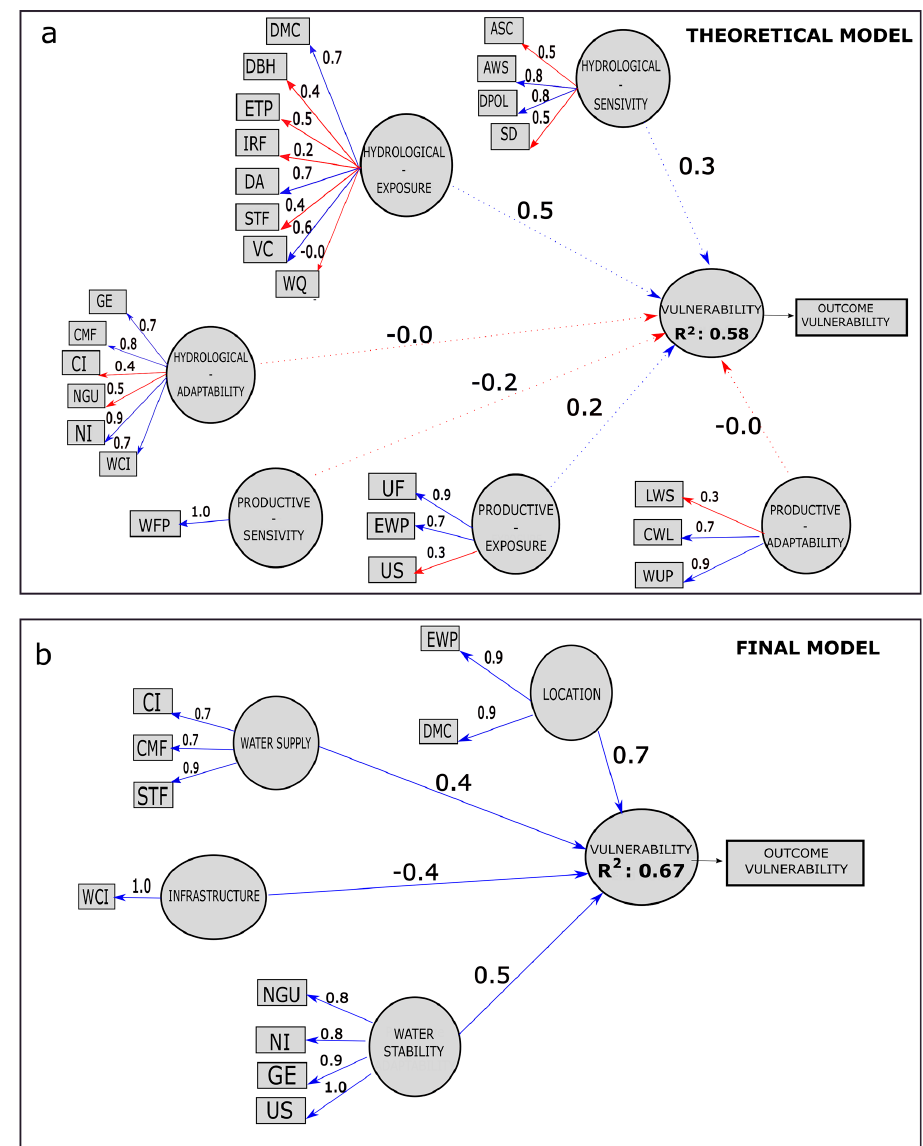
Figure 5. PLSPM-based contextual vulnerability of water security to drought. Circle: construct (latent